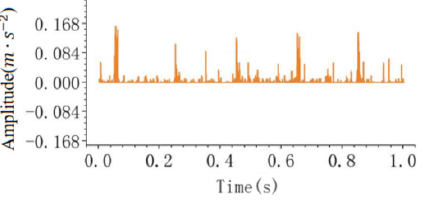
Figure 8. Time domain diagram of sparse decomposition results of L1.